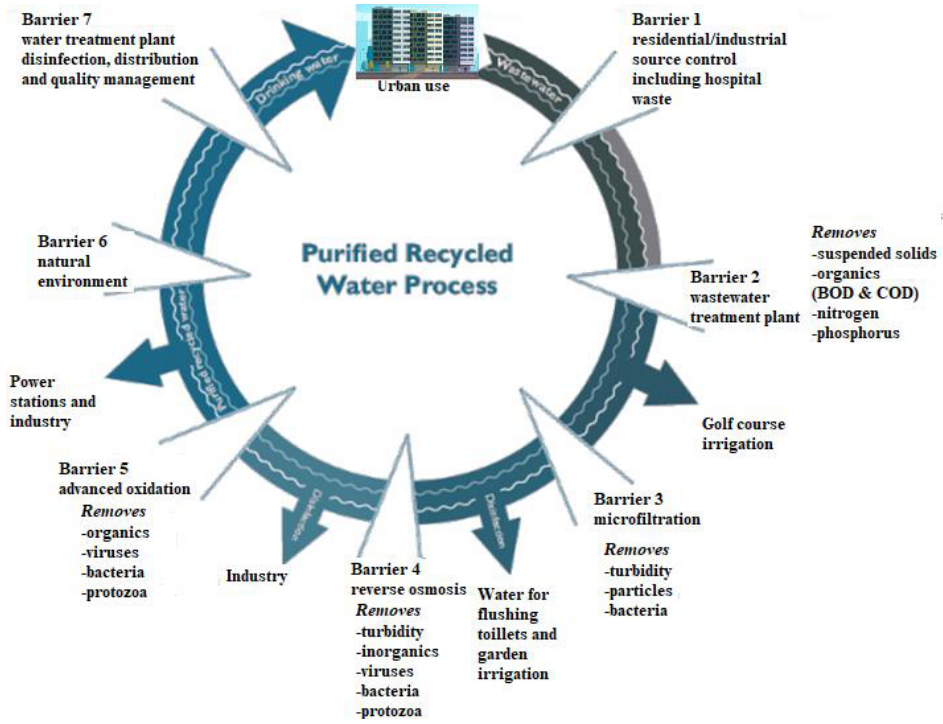
Figure 4. Treatments applied to wastewater in order to be reused (adapted from [105]).